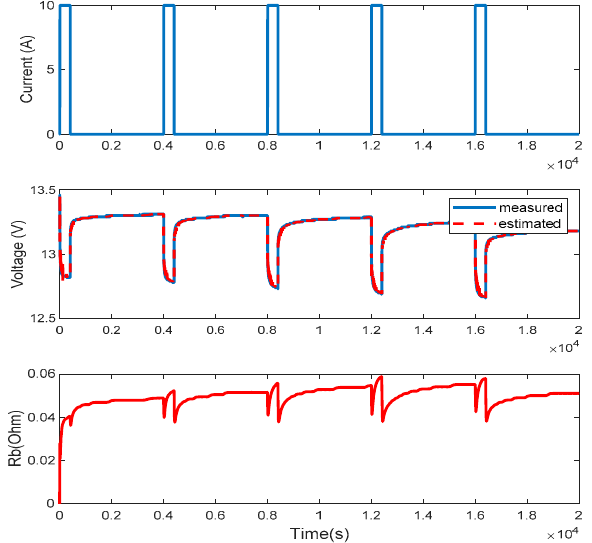
Figure 9. Battery internal resistance identification under constant current (experimental).